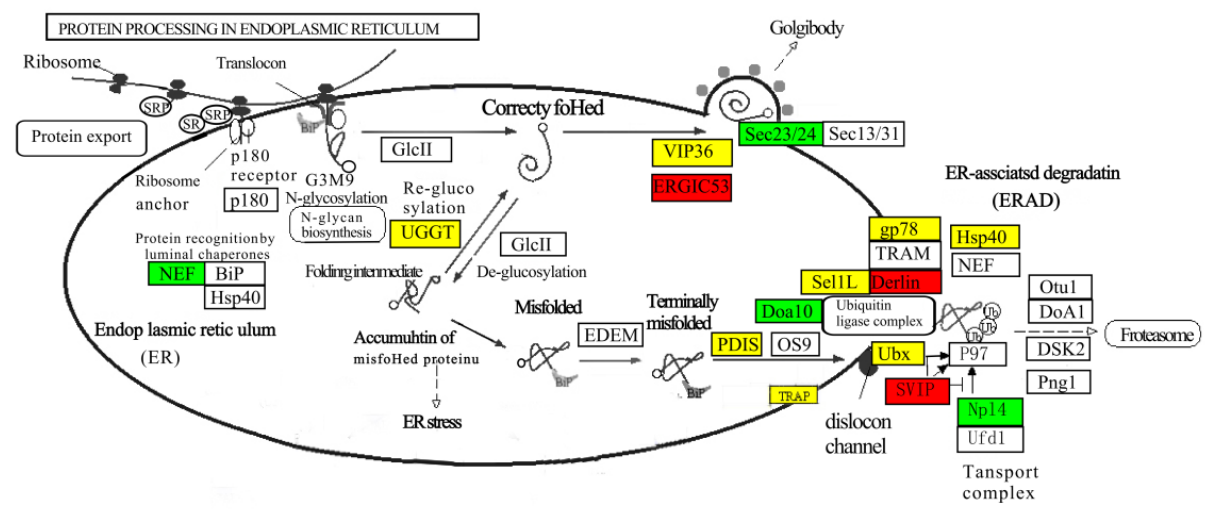
Figure 8. DEGs are involved in the pathway of protein processing in the endoplasmic reticulum. DEGs with up-regulated expression are colored red; DEGs with down-regulated expression are colored green, and DEGs with up/down-regulated expression are colored yellow using female prawn as a control. Genes colored blue indicate that these genes were identified from the full-length transcripts, without differential expression in the nervous system between the sexes of M. rosenbergii.